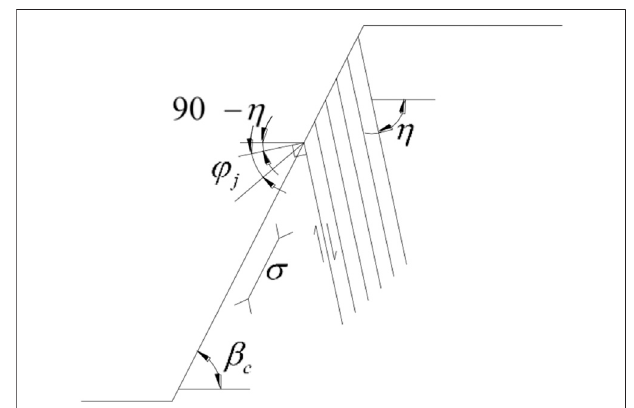
FIGURE 3 | Toppling stability analysis in an anti-dip bedding rock slope (Goodman and Bray,